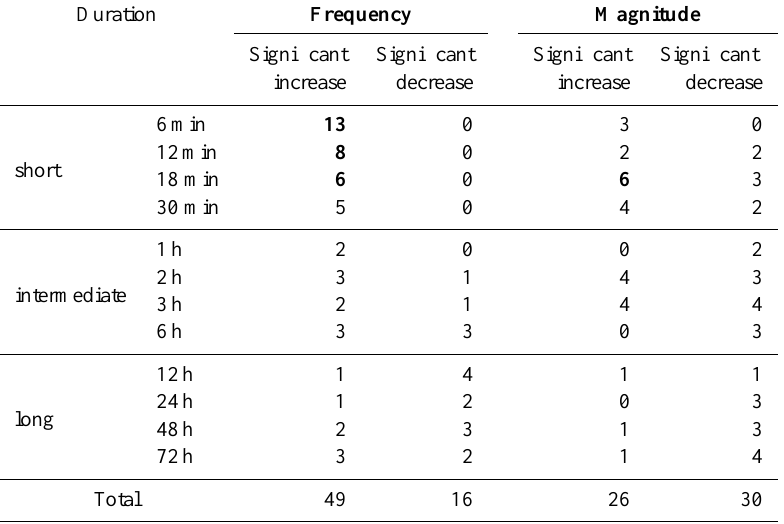
Table 2. Number of sites exhibiting significant increase or decrease in frequency/magnitude of events based on an average of 10 events per year (POT10) and a 90% significance level. Numbers in bold indicate trends are collectively significant.